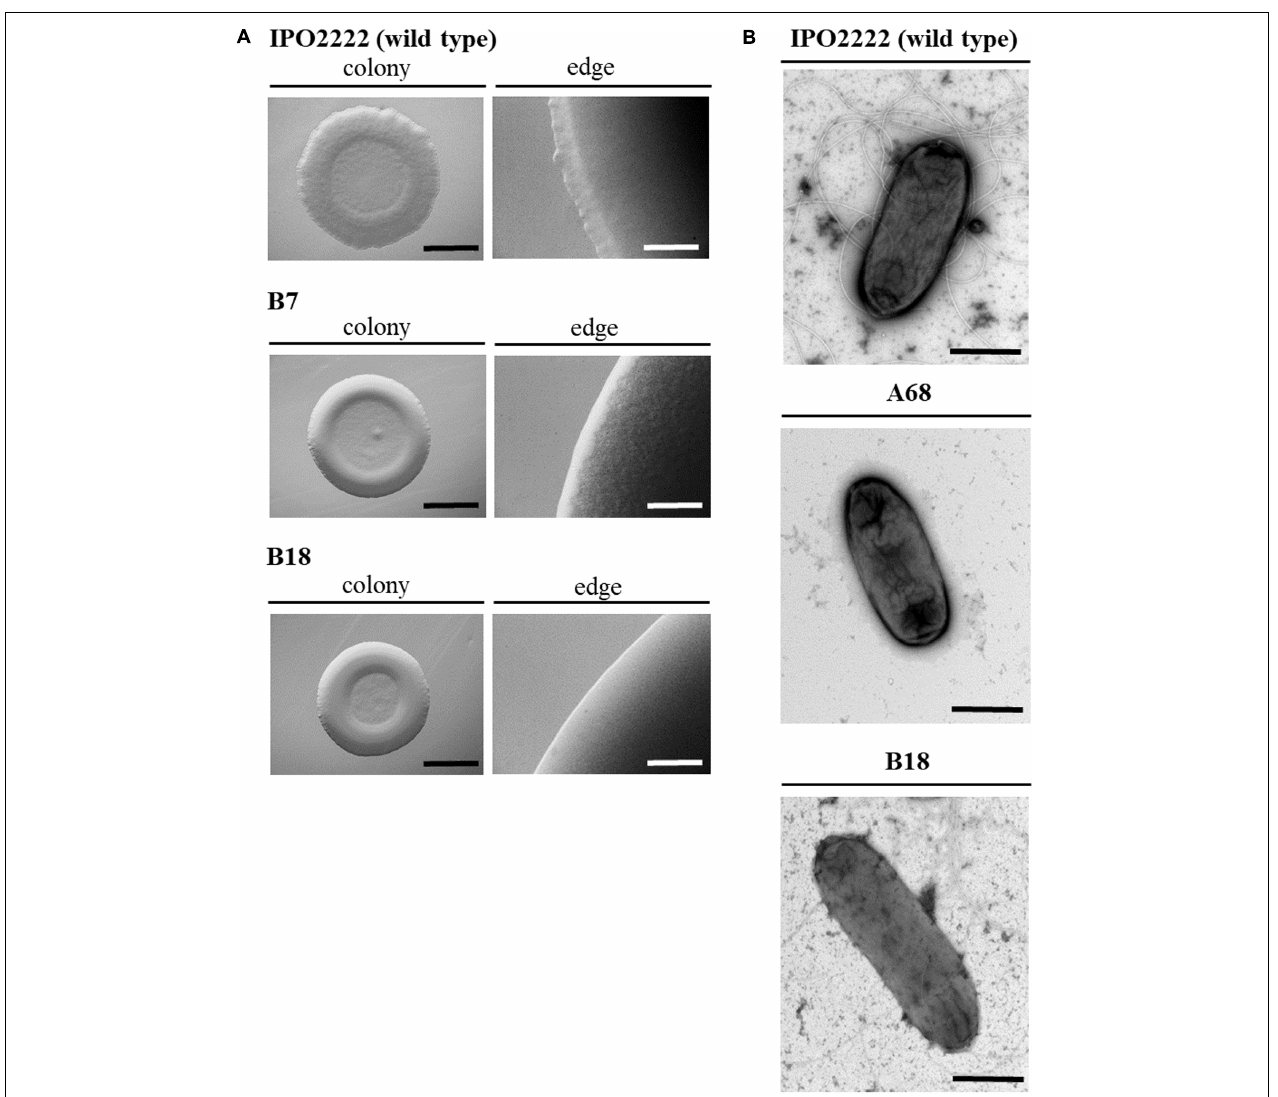
FIGURE 1 | Morphology of Dickeya solani IPO2222 Tn5 transposon mutants B7 and B18 colonies grown on M9 agar with glucose for 24 h at 28 ◦ C visualized with stereomicroscopy with low magnification (10–40 × ); size bar: black – 150 mm, white – 5 mm (A) and individual bacterial cells visualized by transmission electron microscopy (TEM); size bar: 1000 nm. TEM analyses were conducted on wild type and Tn5 mutant cells of D. solani IPO2222 grown overnight in Tryptone Soya Broth (TSB) with shaking (200 rpm) at 28 ◦ C. Photos were taken directly after bacteria collection from liquid cultures. For this, bacteria were adsorbed onto carbon-coated grids (Sigma) stained with 1.5% uranyl acetate and directly examined with electron microscope (Tecnai Spirit BioTWIN, FEI) (B) . The figure shows representative colonies and